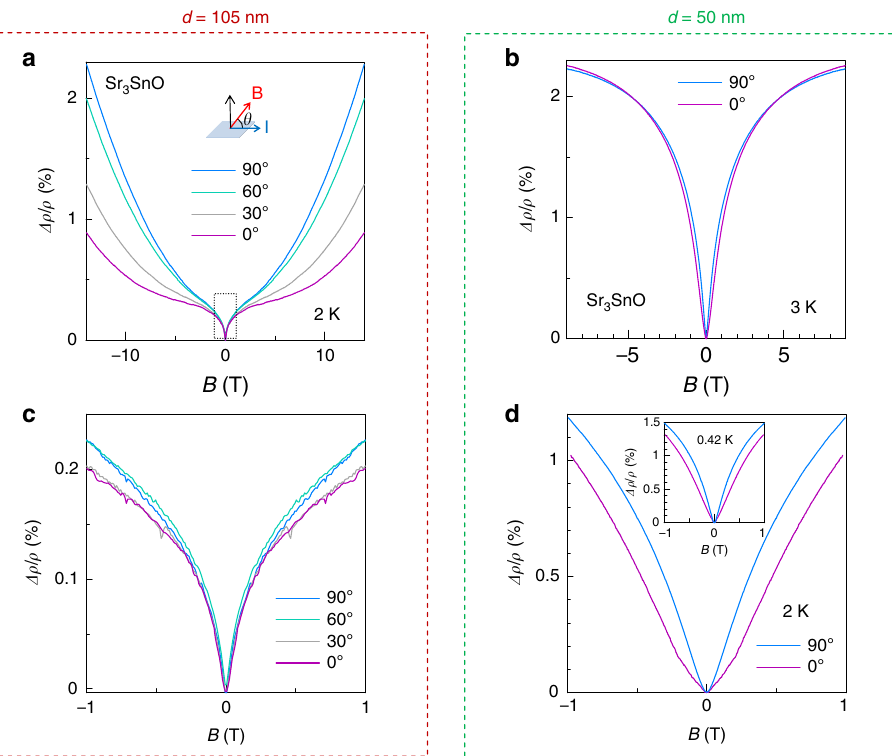
Fig. 3 Angle dependent MR of Sr 3 SnO taken at low temperatures. The MR is normalized with resistance at zero magnetic fi eld. a MR for 105-nm-thick fi lm and b 50-nm-thick fi lm for a wide- fi eld range ( B > 9 T). The inset in ( a ) shows the orientation of current ( I ) and magnetic fi eld ( B ) with respect to thin fi lm (shown as a slab). c Zoom-in of the low- fi eld MR indicated with dashed square in ( a ). d The low- fi eld MR for the 50-nm-thick fi lm at 2 K. The inset of ( d ) shows MR at 0.42 K, in which the qualitative difference between the data for different angles remain unchanged compared with that of 2 Fig. 4e – o. From the estimate of the mean free path for each sample ( l = 0.9 – 4.4 nm), the low- fi eld regime used for the fi t was chosen to be B < 0.1 – 0.5 T ( l B = 41 – 18 nm), corresponding to l B